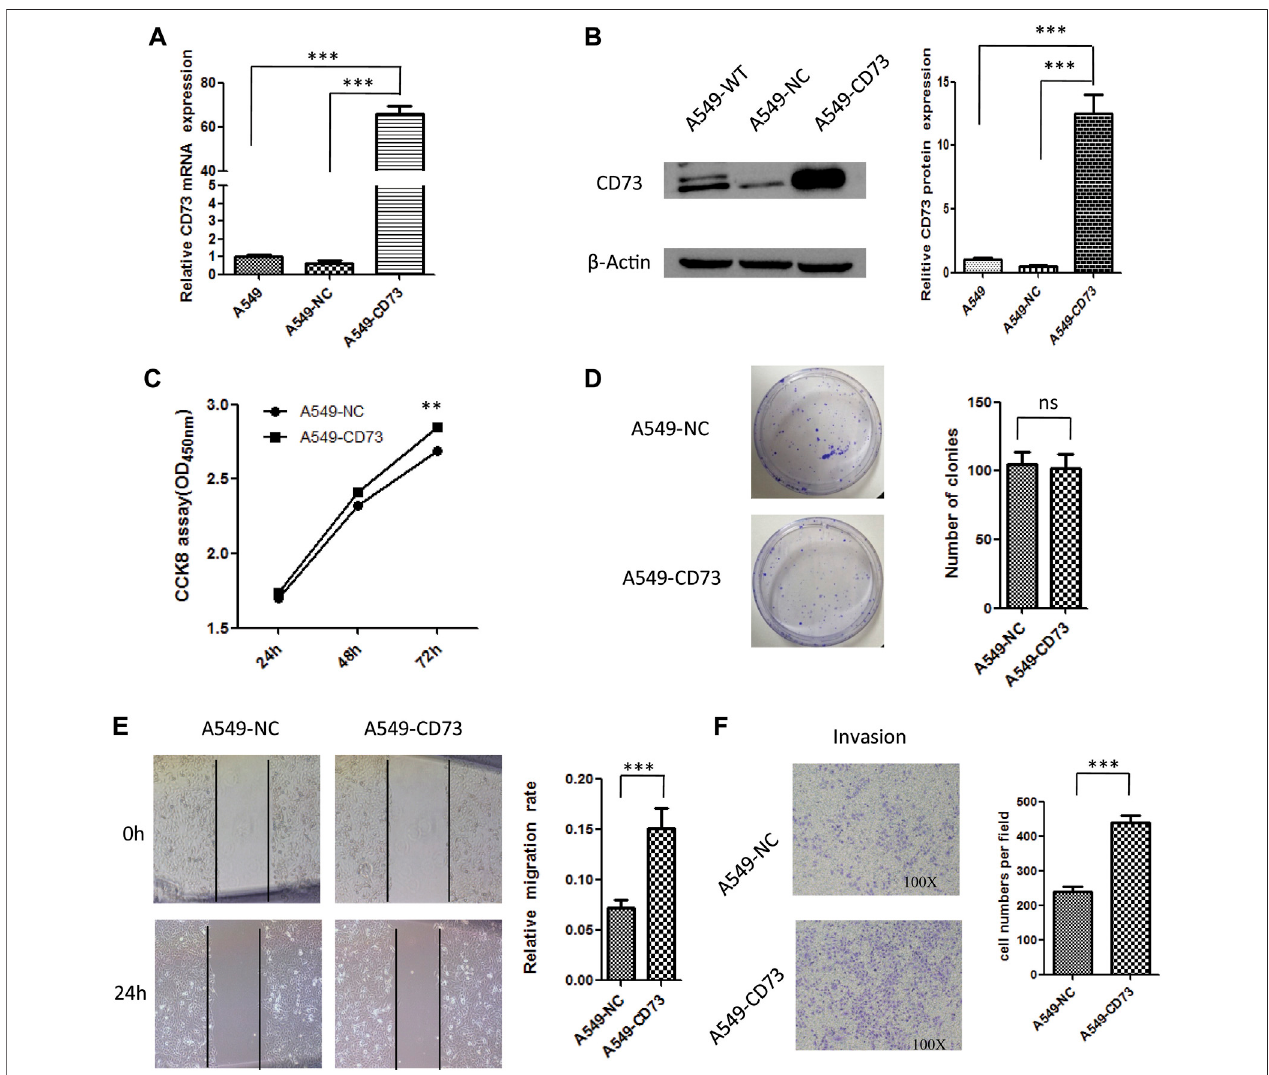
FIGURE 3 | The effect of CD73 overexpression on biological behaviour of A549 cells. (A) CD73 mRNA expression levels were detected by q-RT-PCR. (B) CD73 proteinexpressionlevelsweredetectedbywestern-blot. (C) TheeffectofCD73overexpressiononcellsproliferation. (D) TheeffectofCD73oncolonyformation. (E) The effect of CD73 on cells migration. (F) The effect of CD73 on cells invasion. ns: no signi fi cant difference; ** p < 0.01; *** p <